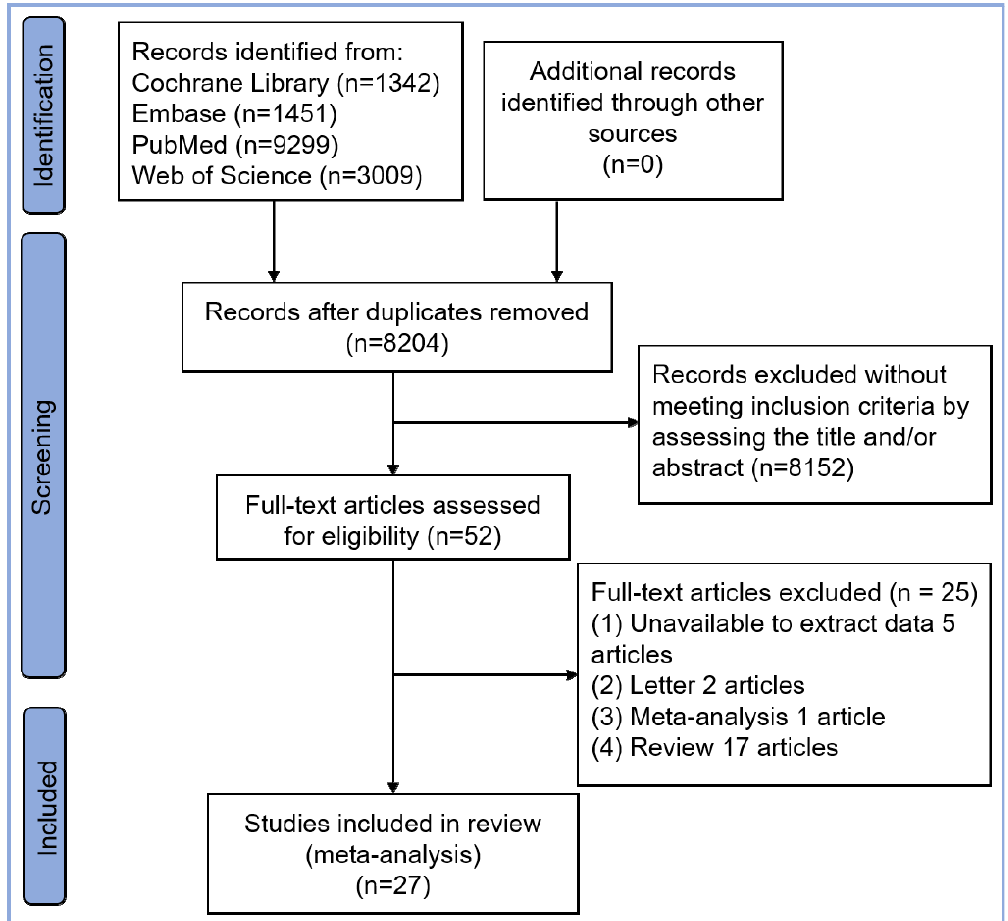
Figure 1. Flowchart of study selection.